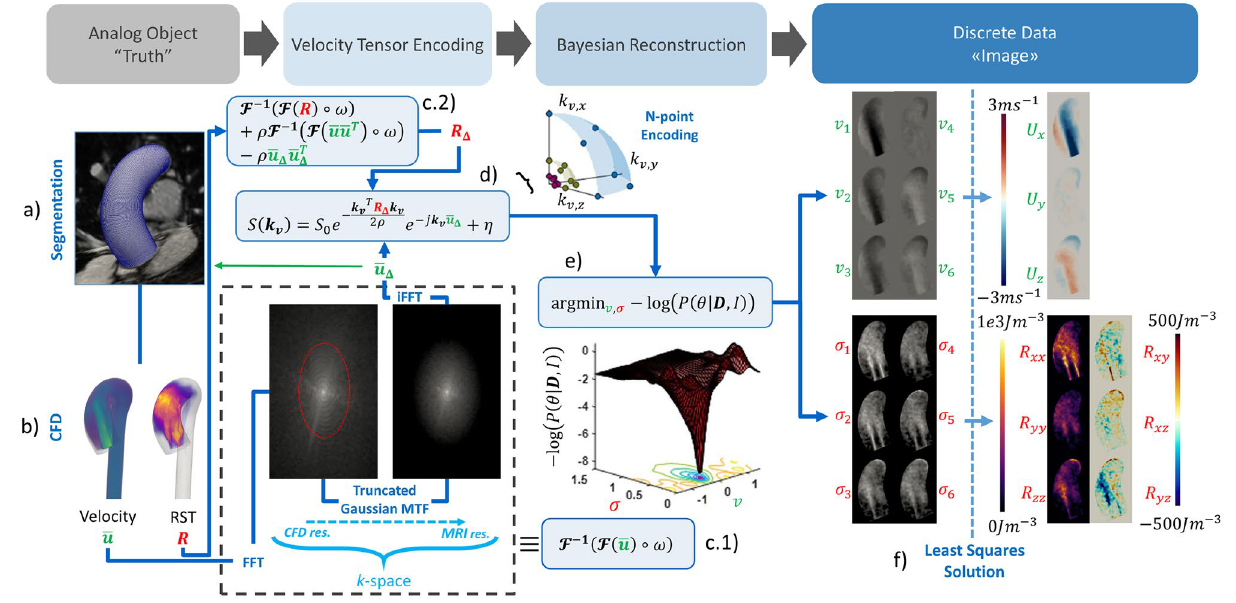
Figure 1. Pipeline for generation of synthetic patient-specific pulsatile mean and turbulent 4D flow MRI datasets. ( a ) Patient-specific segmentation and mesh generation. ( b ) Large Eddy Simulation CFD simulation to obtain mean velocity u and Reynolds shear tensor R . ( c ) Band-limited projection of velocity ( u (cid:31) ) and Reynolds stress tensor ( R (cid:31) ) in the spatial frequency domain (k-space) upon Fourier transform F . ( d ) Signal model to generate MRI signal, S, for a given velocity encoding vector, k v , fluid density, ρ , and complex-valued white Gaussian noise, η . ( e ) Bayesian reconstruction of voxel mean velocities, ν , and intra-voxel variances and co-variances, σ 2 , and ( f ) their projection onto Cartesian coordinates using a least squares solution approach to obtain mean velocity vector U and Reynolds stress tensor R